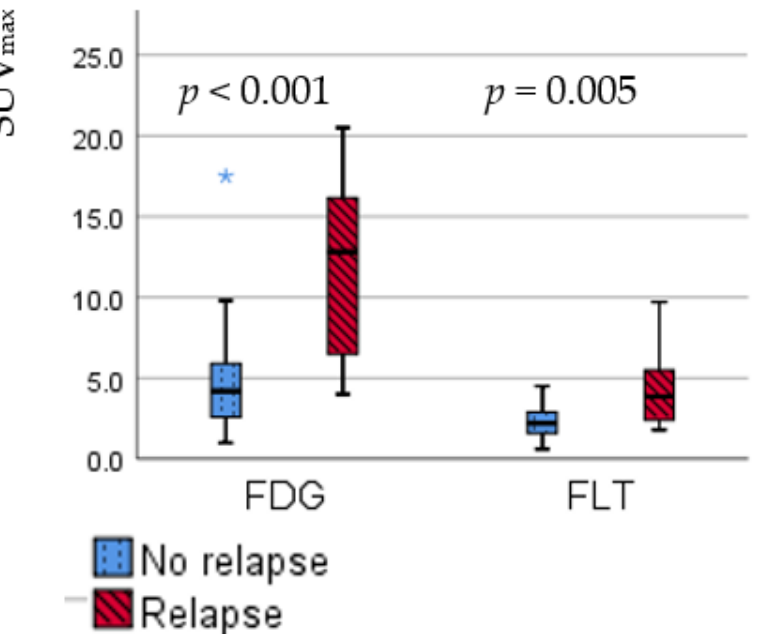
Figure 5. Boxplots of FDG- and FLT-SUV max in HDV with relapse vs. HDV without relapse in patients with irradiated lung cancer. Table 2. PET-parameters in intrapulmonary malignant lesions in patients with relapsed lung cancer.